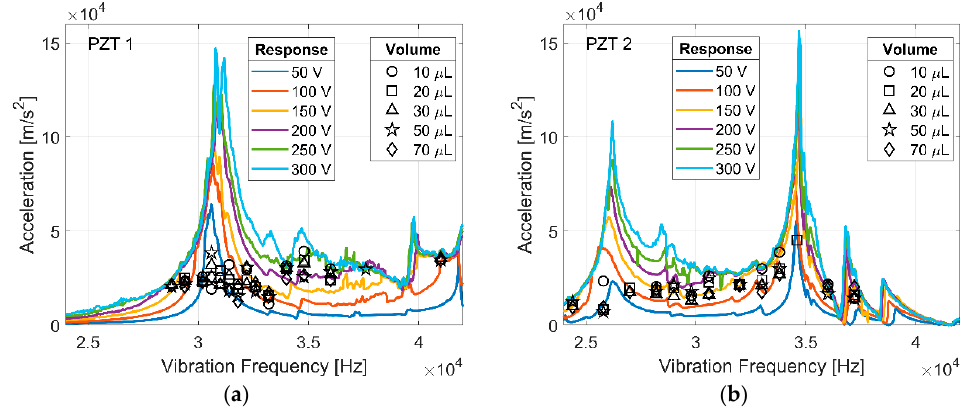
Figure 5. The frequency response (colored lines) of PZT 1 ( a ), and PZT 2 ( b ) at varying driving amplitudes,